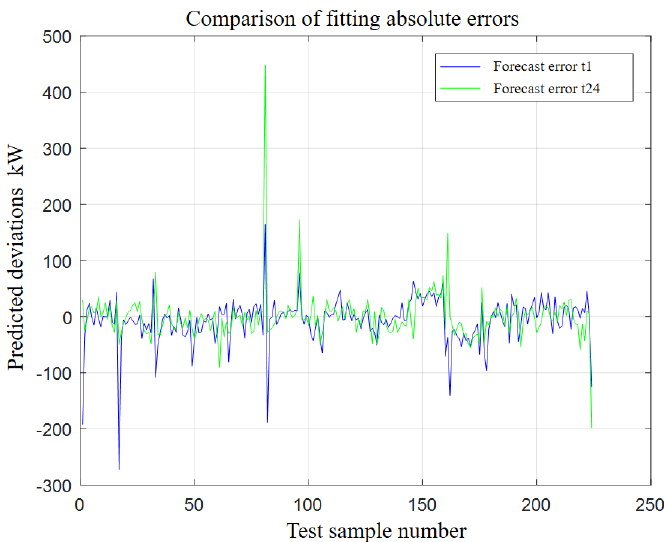
Figure 41. The comparison of the absolute error of fitting the training set.